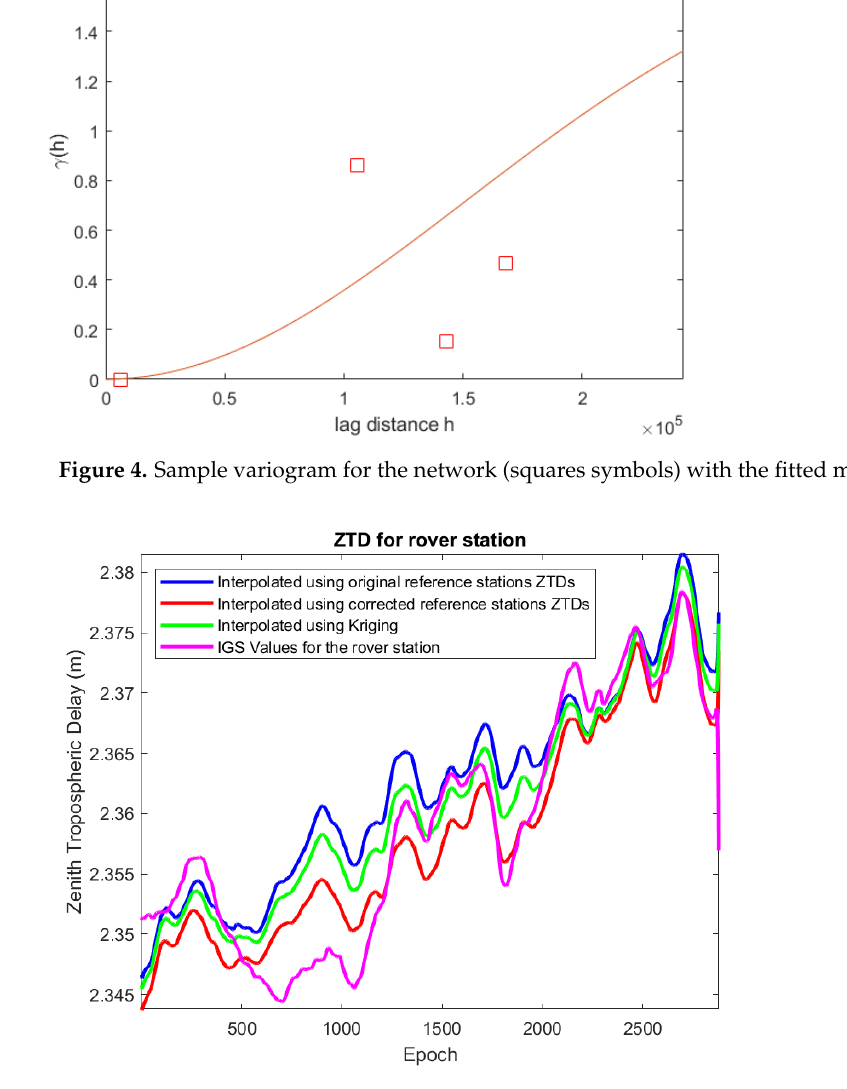
Figure 5. IGS Zenith tropospheric delays for rover station compared to the interpolated